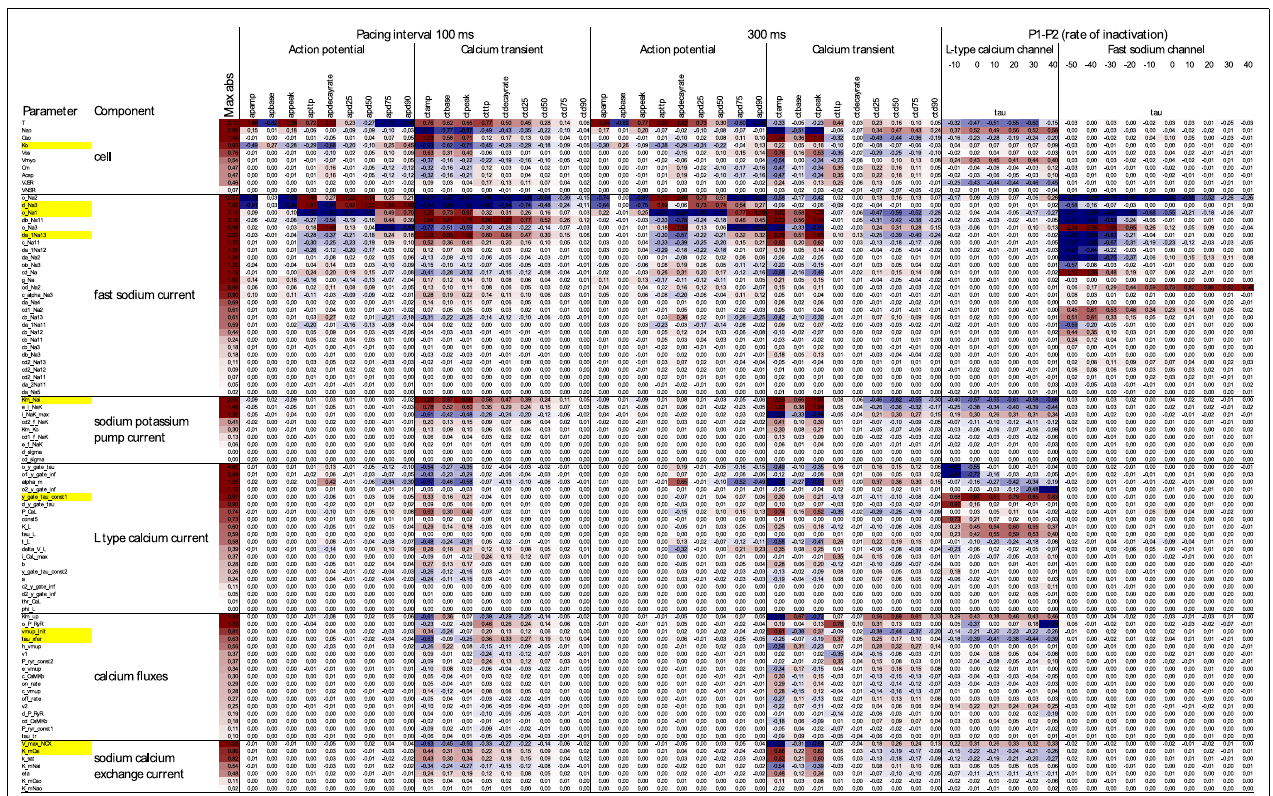
offset parameters). Parameters are ordered within components by their highest absolute elasticity with respect to any phenotype. See Supplementary Material for the full table, annotated with physical units, baseline values, and whether quantities were considered on relative or absolute